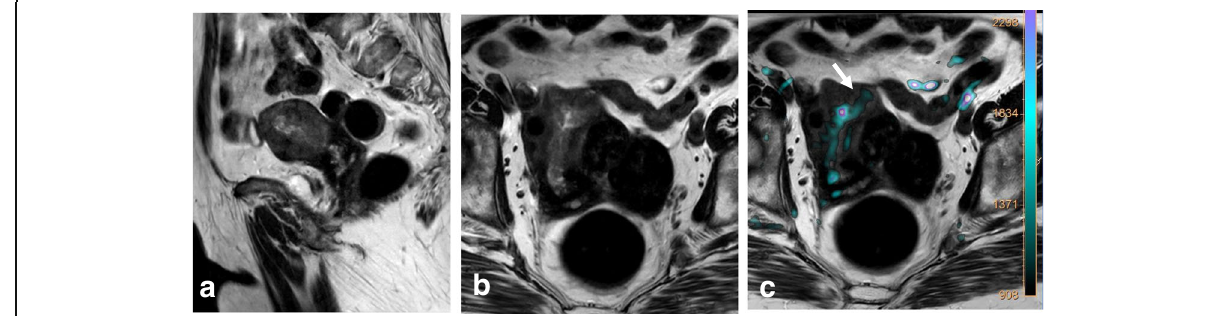
Fig. 5 FIGO IB tumor exhibiting left cornual extension. a Axial oblique T2WI. b Coronal T2WI. c Fused T2WI-DW images show endometrial tumor (arrow), which was difficult to delineate on individual